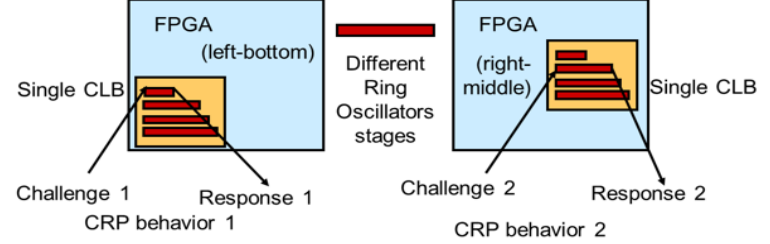
Figure 4. General FPGA-based dynamic ROPUF scheme.